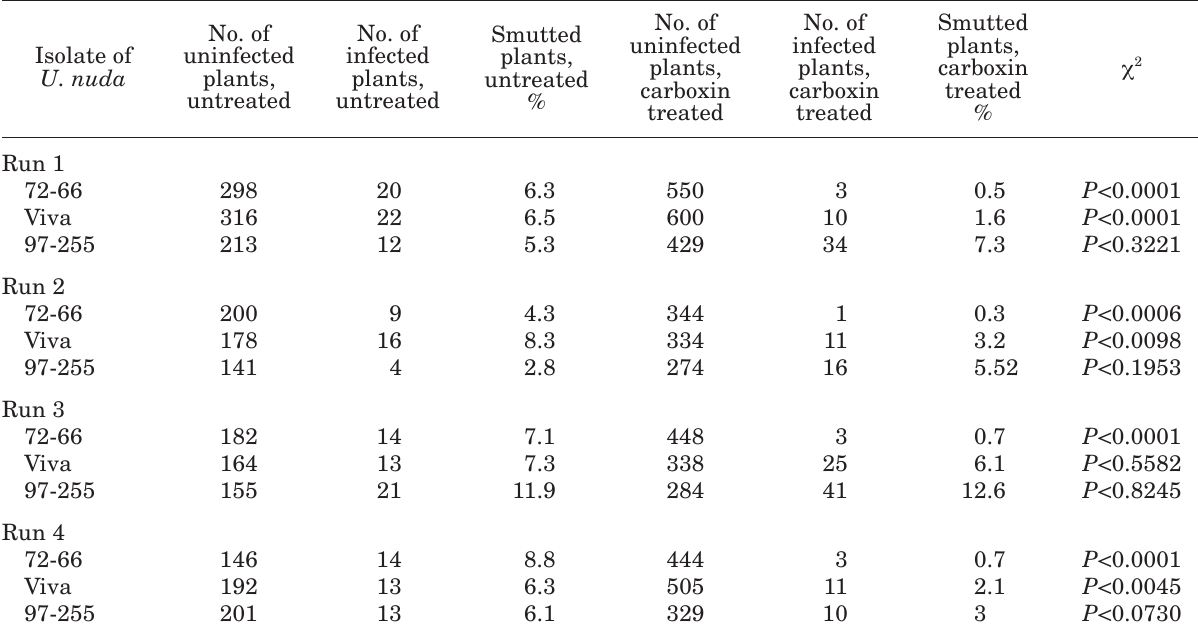
Table 1. Percentage of plants with smutted heads arising from seed of barley cv. Regal infected with Ustilago nuda isolates 72-66, Viva or 97-255, untreated or treated with carboxin (Vitavax SS). No.